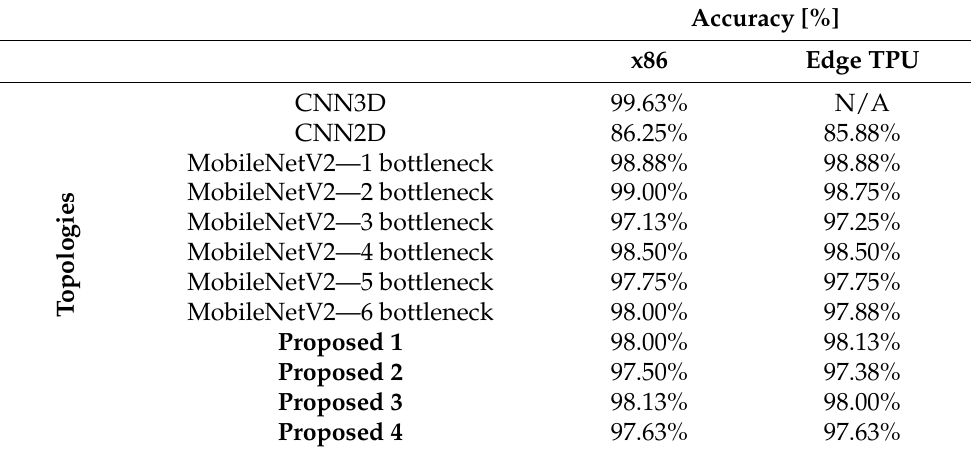
Table 1. Comparative characteristics of accuracies for the non-optimized and the optimized